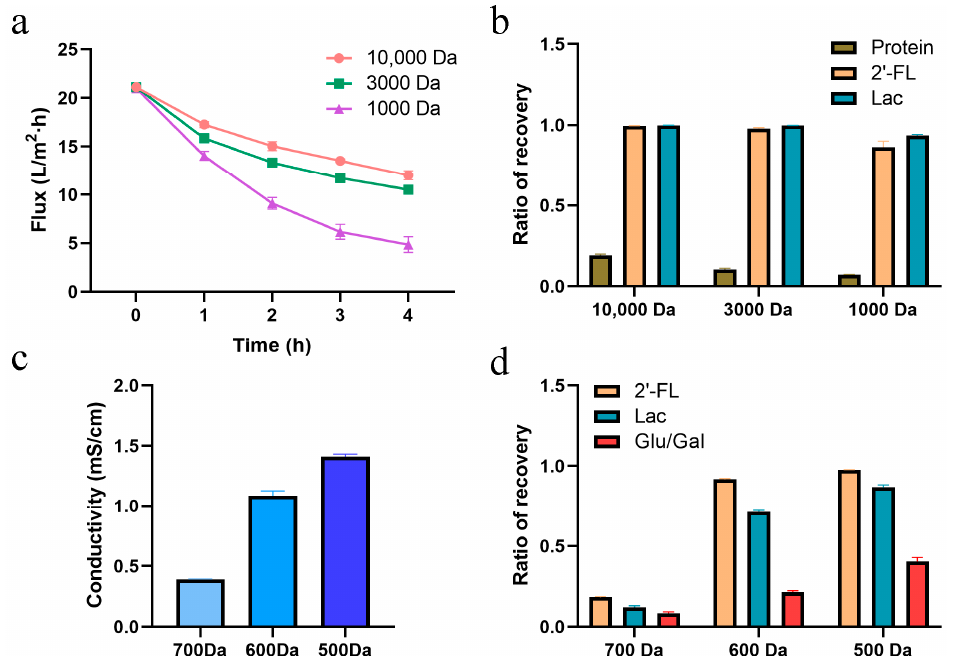
Figure 2. Filtration results from different membrane modules. ( a ) Results of flux changes with time for membrane modules with different pore diameters; ( b ) Ratio of recovery of different substances filtered by different ultrafiltration membranes; ( c ) Conductivity of residual solution filtered by different nanofiltration membranes; ( d ) Ratio of recovery of different substances filtered by different nanofiltration membranes.